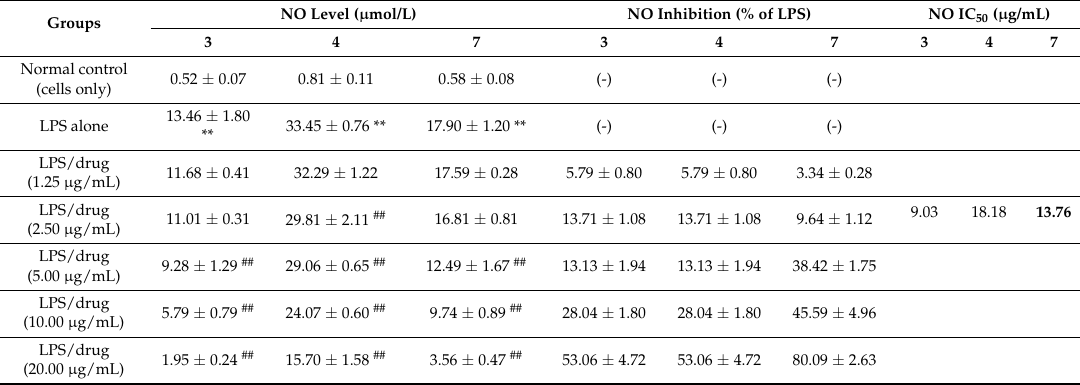
Table 2. Effects of compounds 3 , 4 , and 7 on LPS-induced NO release of macrophages 1.